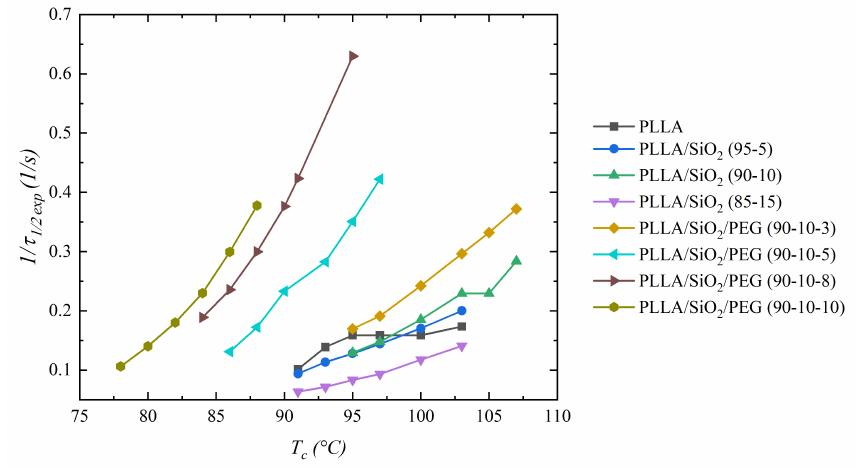
Figure 5. Values of 1/ τ 1/2 exp as a function of the isothermal crystallization temperature (T c